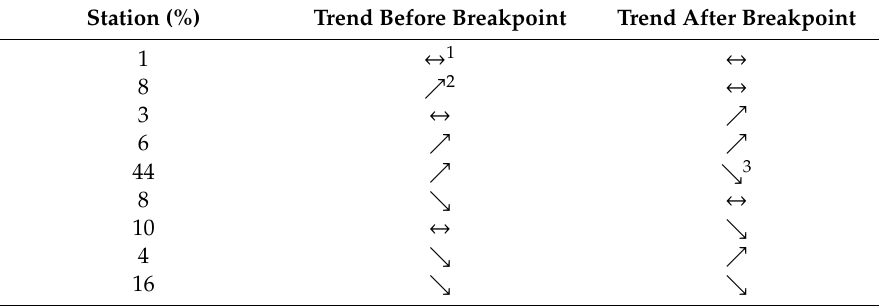
Table 7. Characteristics of the trend before and after